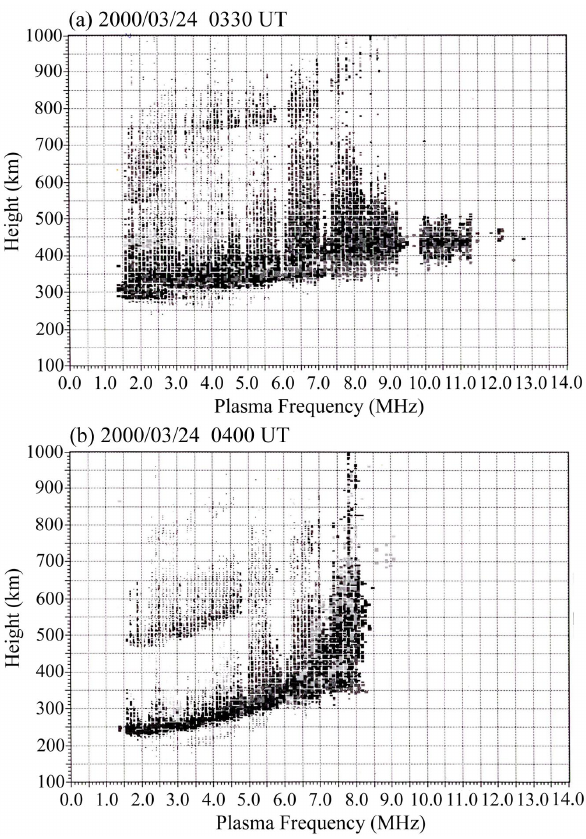
Fig. 2. Two ionogram examples of Jicamarca BSSF at (a) 03:30 and (b) 04:00 UT on 24 March 2000.